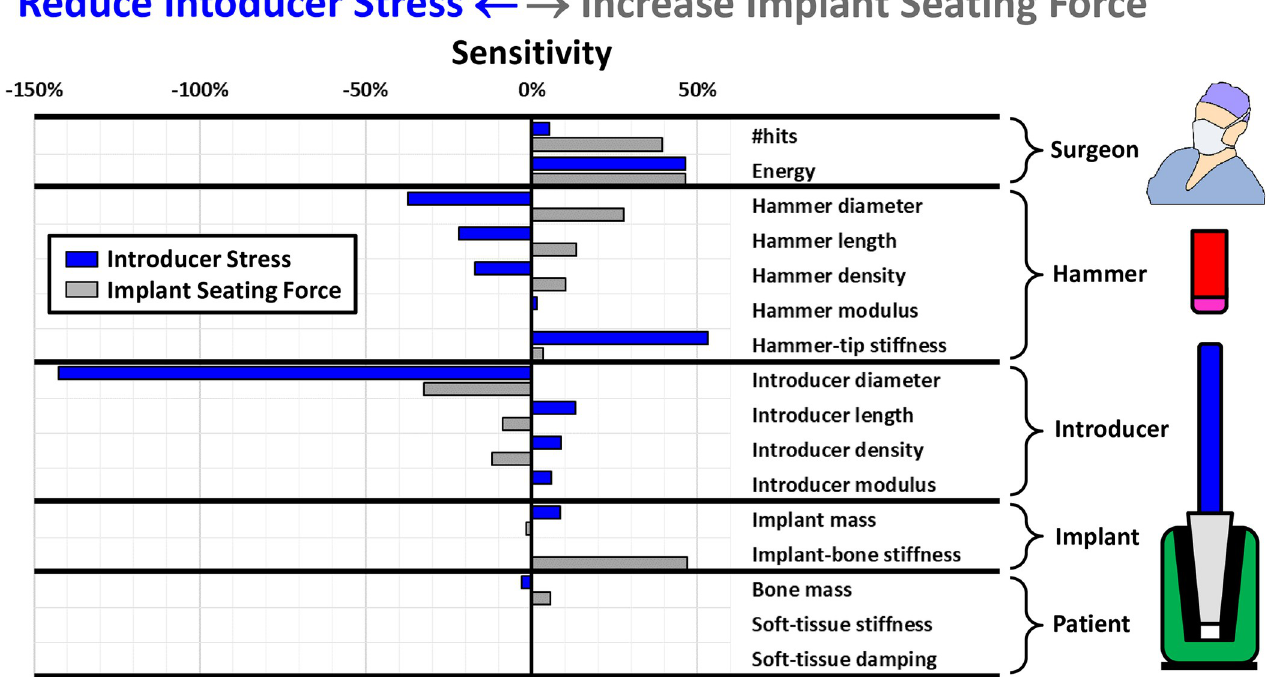
Fig 4. Sensitivities of introducer stress and implant seating force to each parameter variation are shown. Sensitivity is the slope of the best fit through a plot of percentage change in output vs percentage change in input, relative to nominal values. The aim of the study is to find parameters that will decrease stresses (blue with negative sensitivity) and increase implant seating force